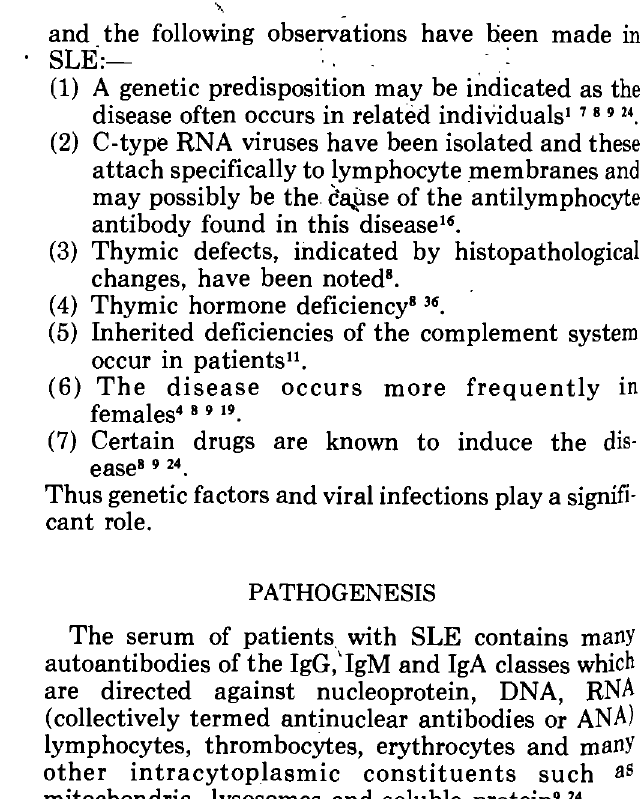
Fig. 1: A schematic summary of the development of humoral and cellular